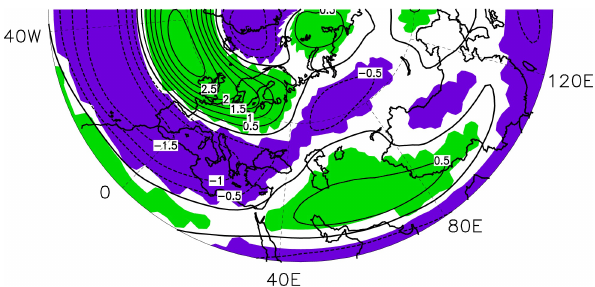
Figure 7. Spatial distribution of the correlation coefficients between the Niño 3.4 index and convergence at 700hPa for the Niño 3.4 index leading for 3 months. Color shading indicates significance at the 0.05 level.